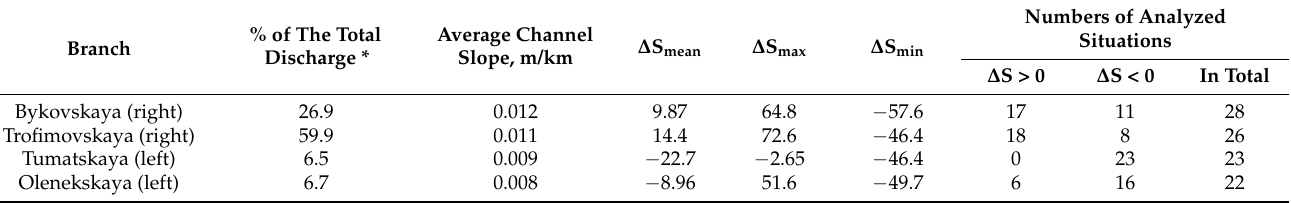
Table 6. Surface suspended sediment concentration changes along the main distributaries of the Lena